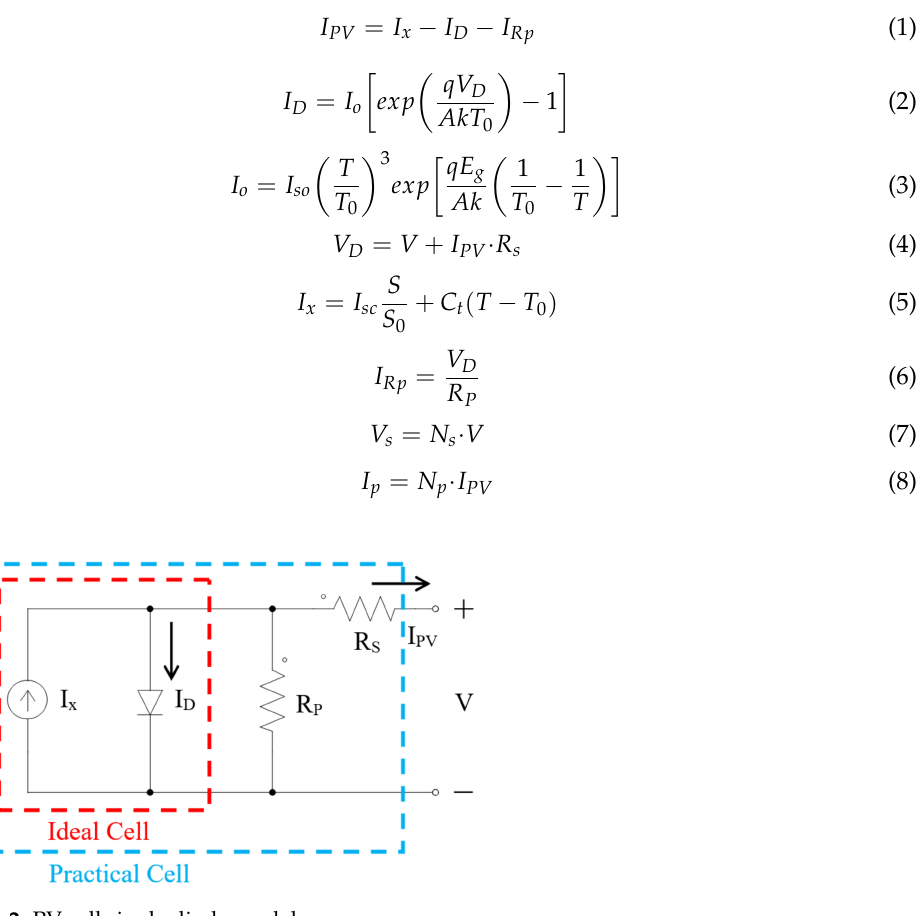
Figure 2. PV cell single diode model.